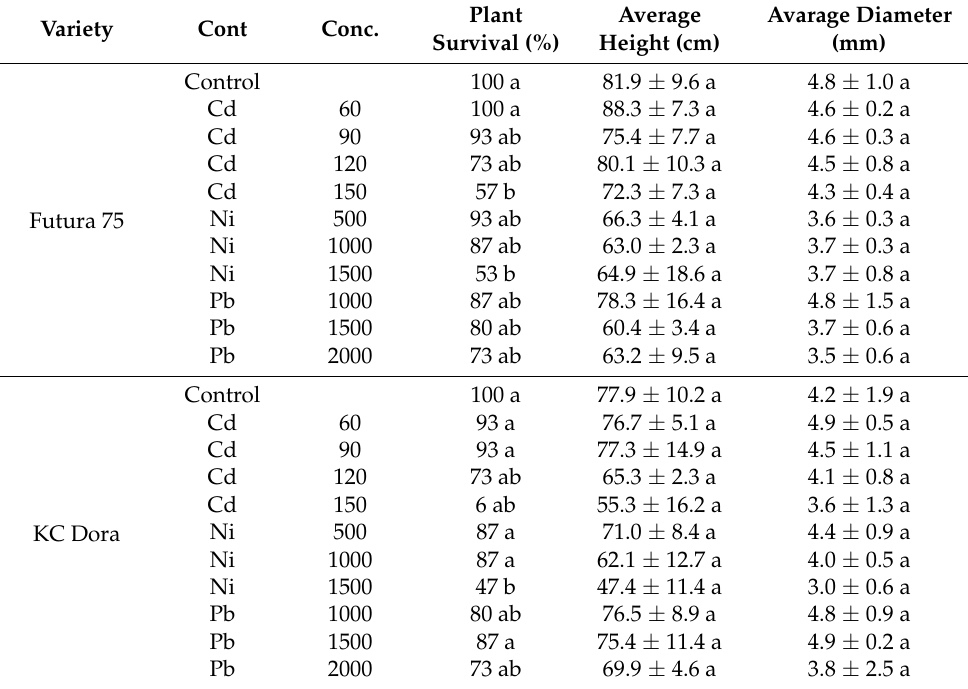
Table 4. Plant survival per pot, height of the plant, and basal diameter. Multiple comparisons between means were performed within the different morphological measurements. Different letters indicate significant differences between the means (according to HSD at p ≤ 0.05). Plant Average Avarage Diameter Variety Cont Conc. Survival (%) Height (cm)